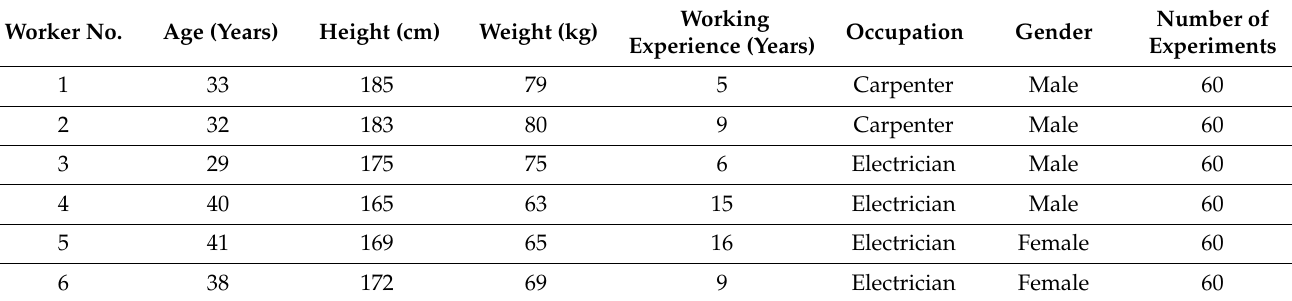
Table 1. The demographic information for participants in the experiment.